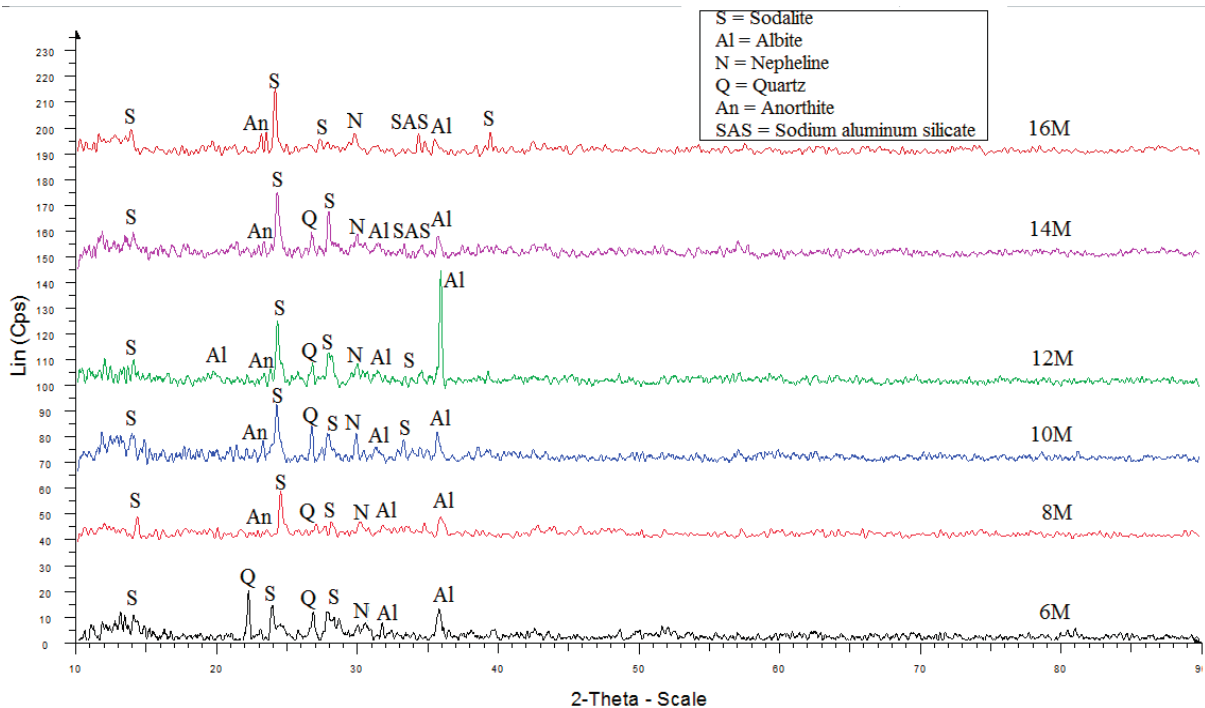
Figure 4. XRD pattern of ALGA produced at various NaOH